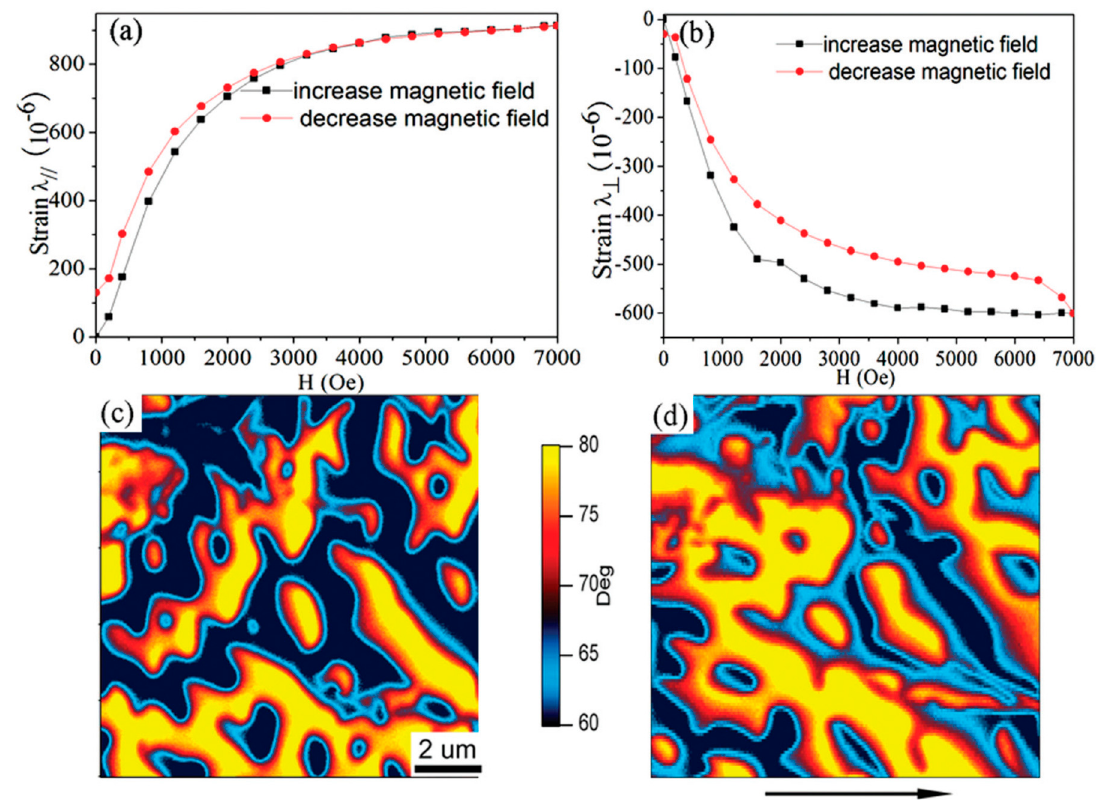
Figure 3. The magnetostrictive strain and MFM phase images of the Terfenol ‐ D disk at saturated magnetization ( a ) parallel, ( b ) perpendicular to the applied magnetic field; ( c ) MFM phase image before, ( d ) after magnetization [67].